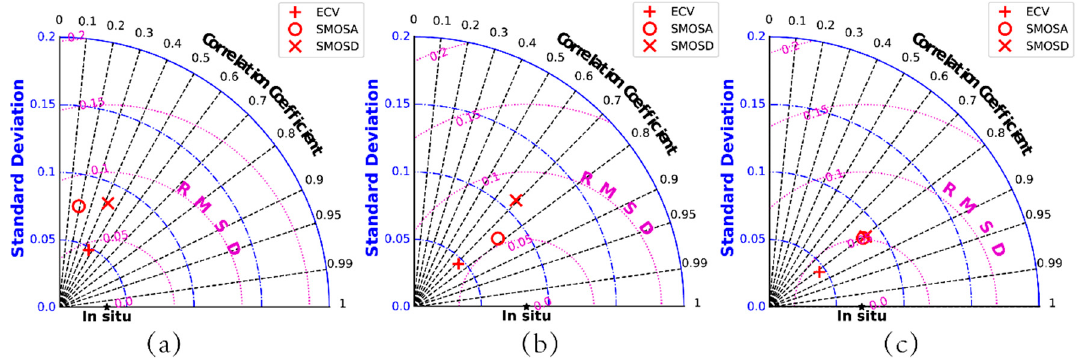
Figure 5. Taylor diagrams displaying correlation coefficients, standard deviations, and root mean standard deviations between three soil moisture products and in situ soil moisture over three networks: ( a ) Adelong; ( b ) Kyeamba; and ( c ) Yanco.